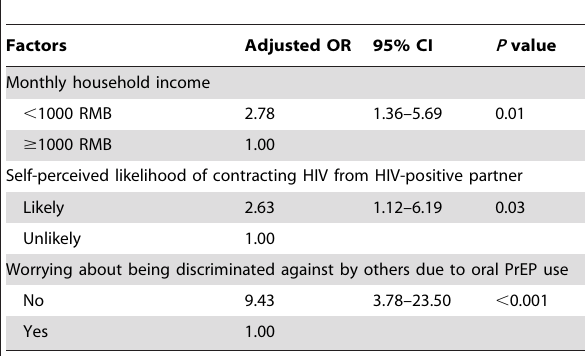
Table 5. Fitted multivariable logistic regression model for predicting willingness to use oral